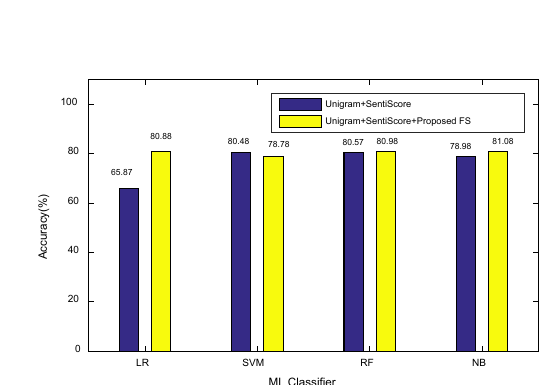
Figure 7. Accuracy Comparison of feature selection techniques on Amazon Product Reviews